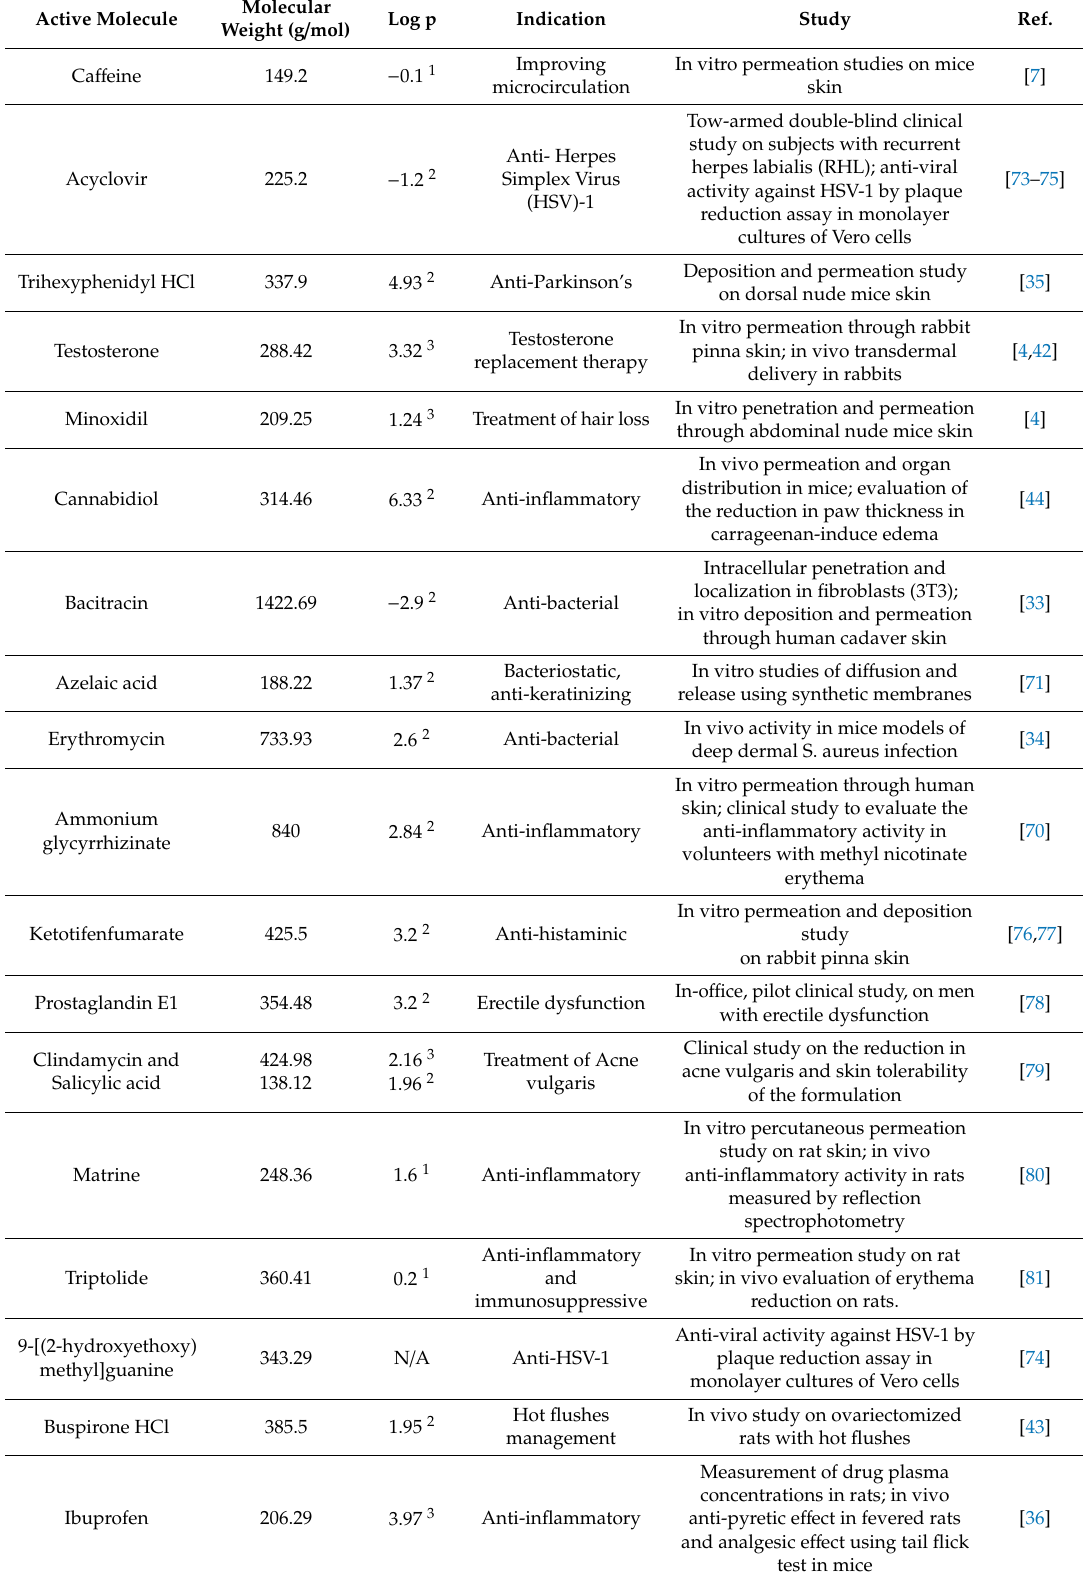
Table2. Activemoleculesincorporatedinethosomesinvestigatedfordermal / transdermaladministration: in vitro, in vivo preclinical and clinical studies (presented in chronological